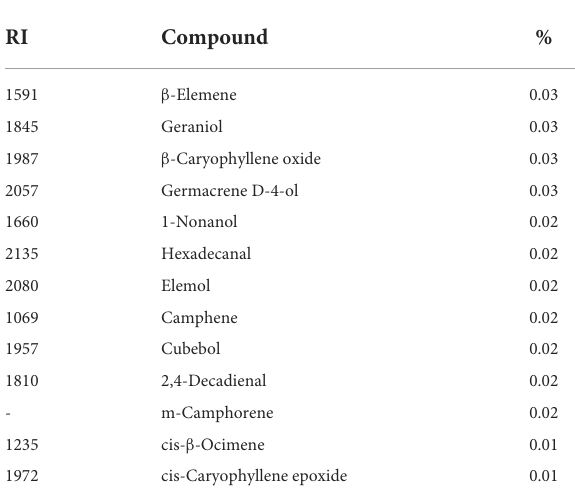
TABLE 2 Volatile composition of orange essential oil